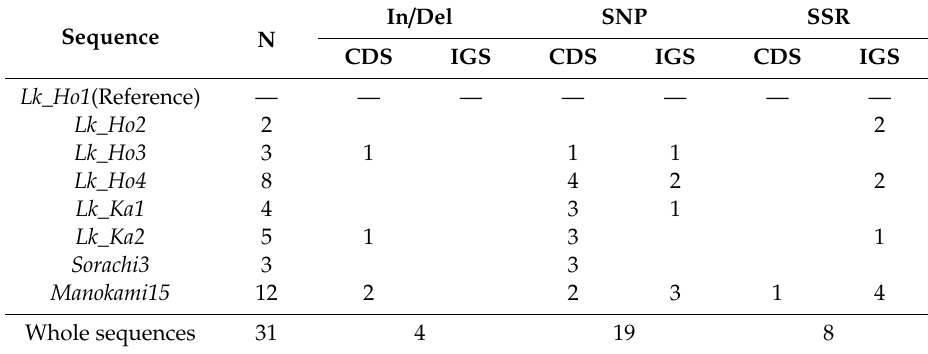
Table 1. Genetic variation among chloroplast genomes of Japanese larch. CDS: coding sequence; IGS: intergenic spacer; In / Del: insertion or deletion; SNP: single nucleotide polymorphism; SSR: simple sequence